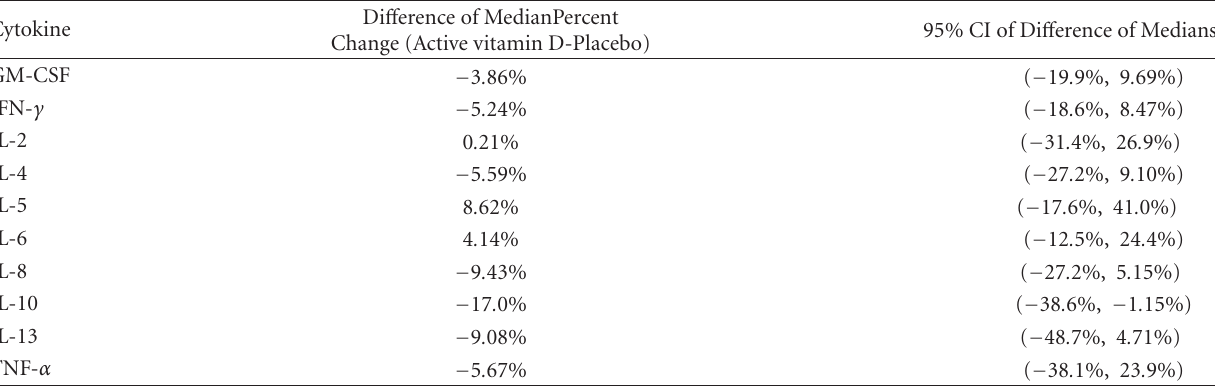
Table 3: Median Di ff erence of Percent Changes (Active vitamin